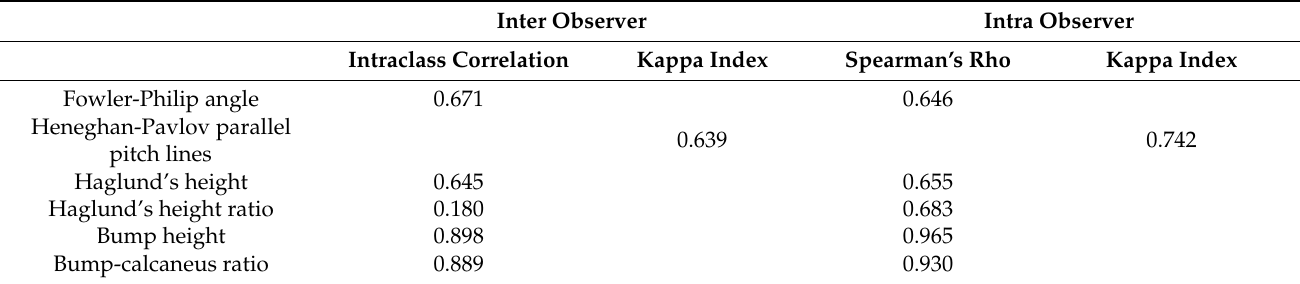
Table 4. Intraobserver and interobserver